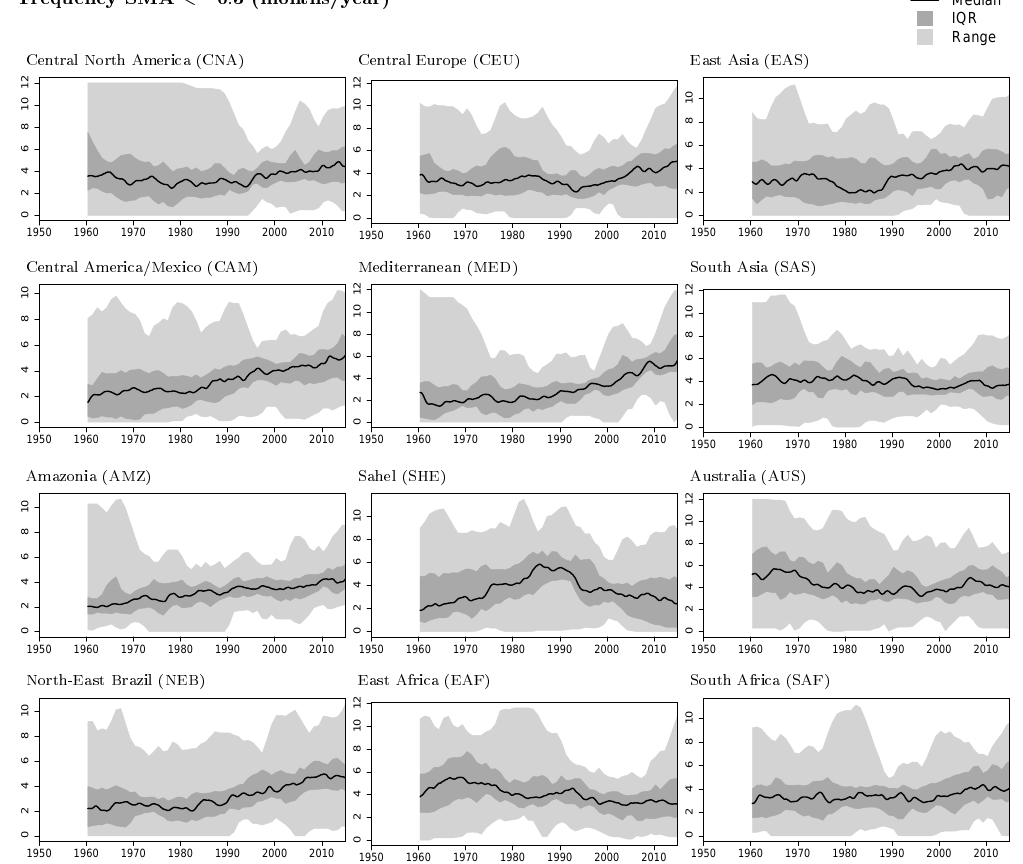
Fig. 6. As Fig. 5, for the occurrence frequencies of months with SMA < − 0.5 in CMIP5 simulations, derived from 10yr moving windows. Frequencies are given as months per year.